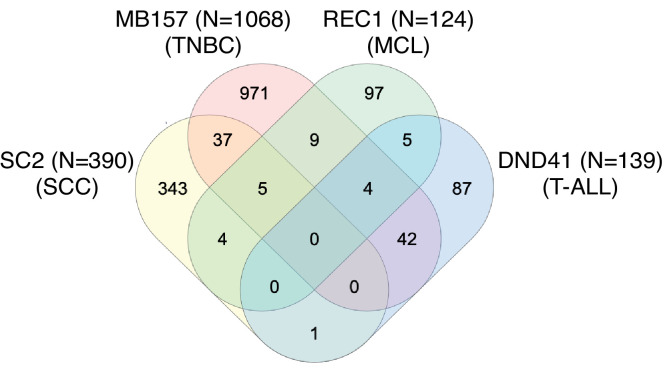
Venn diagram showing the overlap in Notch target genes (defined as log2 change >1 and FDR < 0.05 following GSI washout) in IC8 squamous carcinoma cells (S2 subclone), MB157 triple negative breast carcinoma cells (Petrovic et al., 2019), REC1 mantle cell lymphoma cells (Ryan et al., 2017), and DND-41 T-ALL cells (Petrovic et al., 2019).The lists of overlapping genes are provided in Supplementary file 6.